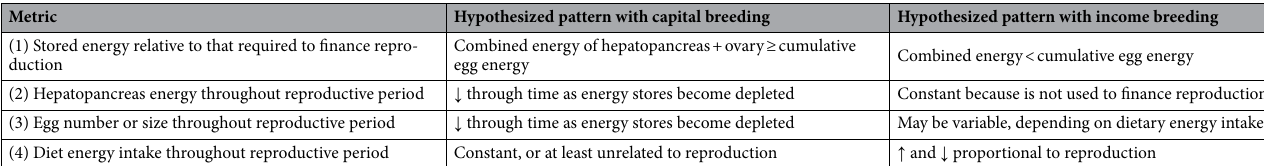
Table 1. Hypotheses tested to distinguish between capital and income breeding strategies.